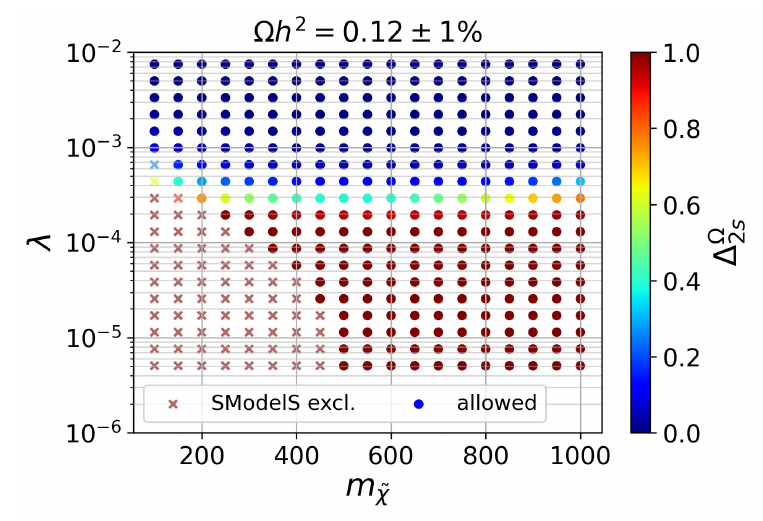
Figure 6: Same as Fig. 5 but with the colour scale showing ∆ Ω